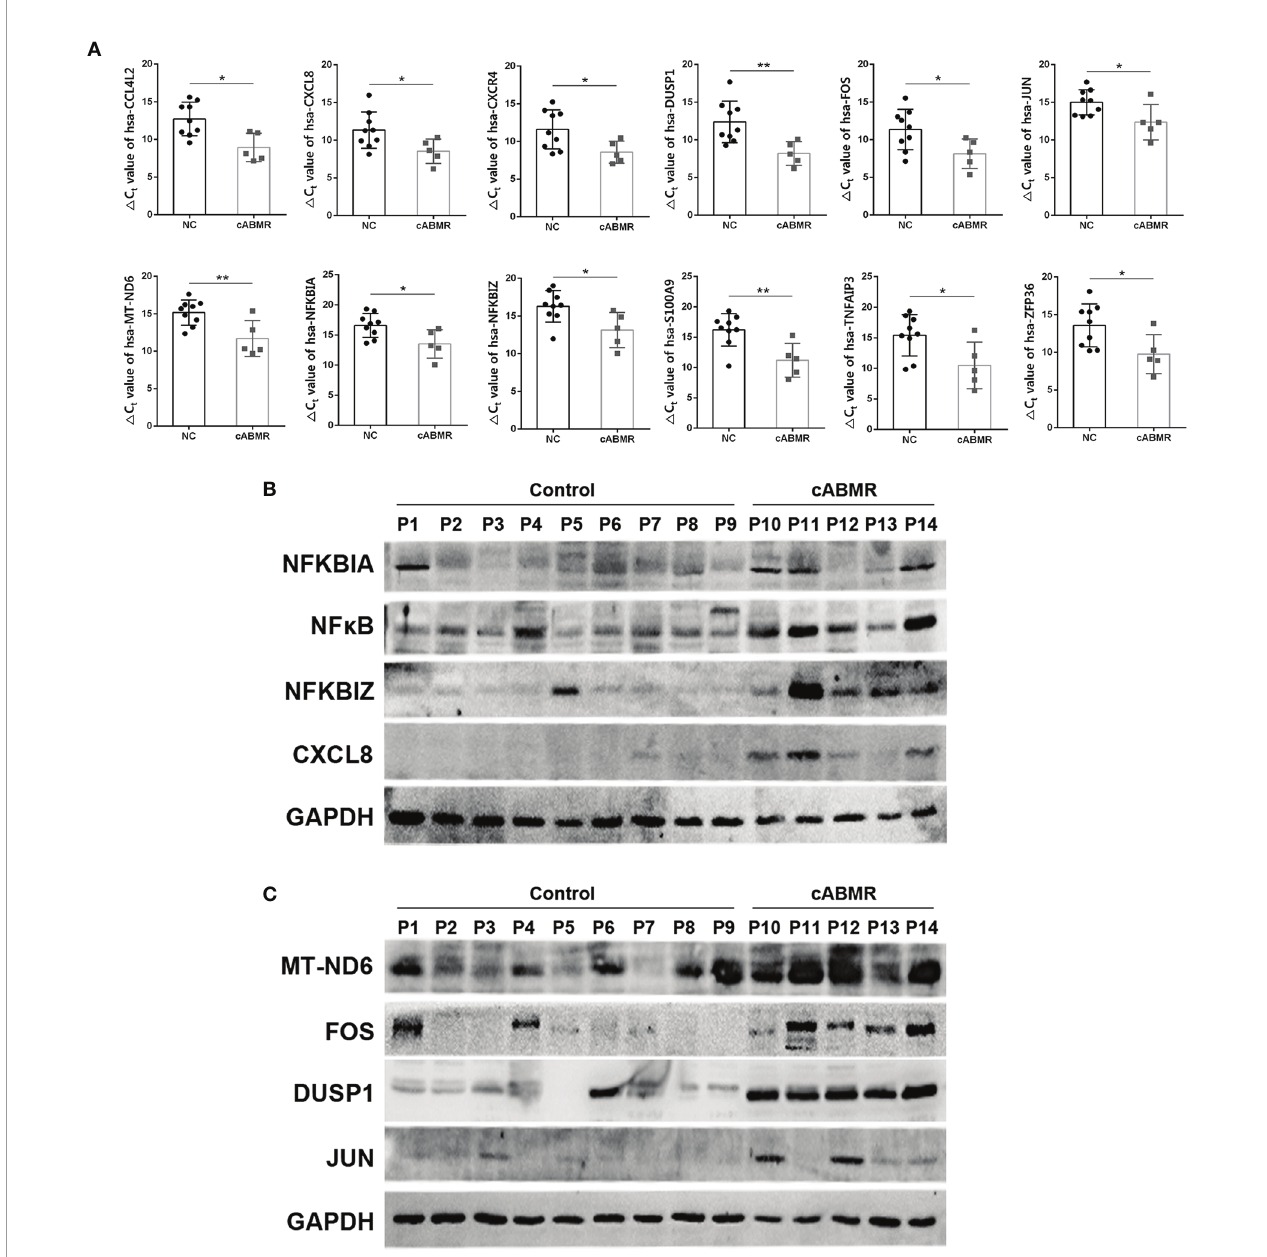
FIGURE 7 | qRT-PCR and Western blot Experiment were performed to verify the changes of differentially expressed genes in cABMR patients. (A) qRT-PCR veri fi ed that MT-ND6, CXCL8, NFKBIA, ZFP36, CXCR4, TNFAIP3, S100A9, NFKBIZ, DUSP1, JUN, FOS, CCL4L2 were up-regulated in peripheral blood of cABMR patients. (B) Western blot veri fi ed that NF k B signaling pathway related protein expression was up-regulated. (C) Western blot veri fi ed that MAPK signaling pathway related protein expression was up-regulated. Data are shown as the mean ± SD ( *P < 0.05, **P < 0.01 vs.